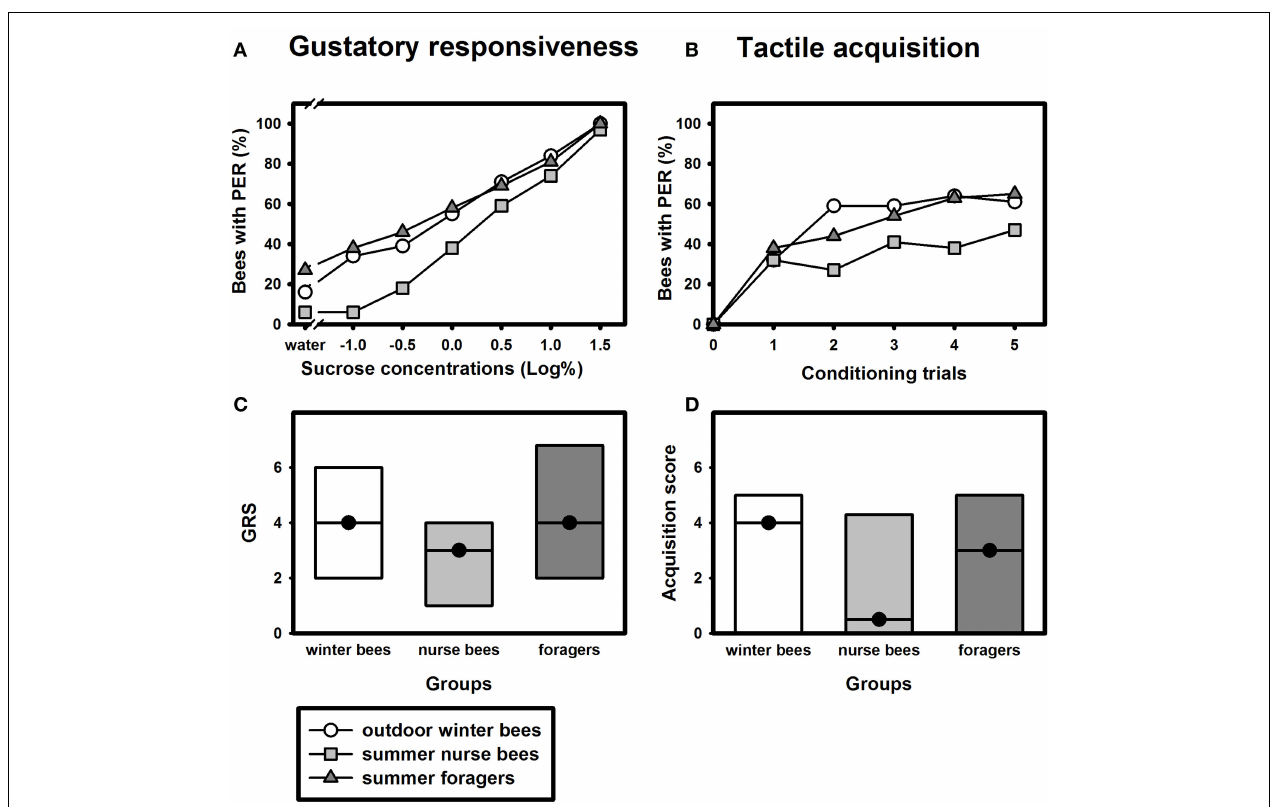
FIGURE 3 | Gustatory responsiveness and tactile acquisition of outdoor winter bees, summer nurse bees and summer foragers. (A) Sucrose-concentration response curves of outdoor winter bees, summers nurse bees and summer foragers. The x -axis displays the sucrose concentration offered to the antennae of each bee. The y -axis shows the percentage of bees showing the proboscis extension response (PER). (B) Tactile acquisition curves of outdoor winter bees, summers nurse bees and summer foragers. The x -axis displays the conditioning trials. The y -axis shows the percentage of